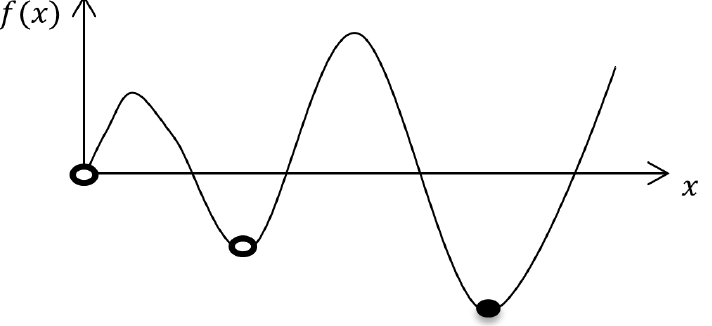
Figure 1. Local and global minimum